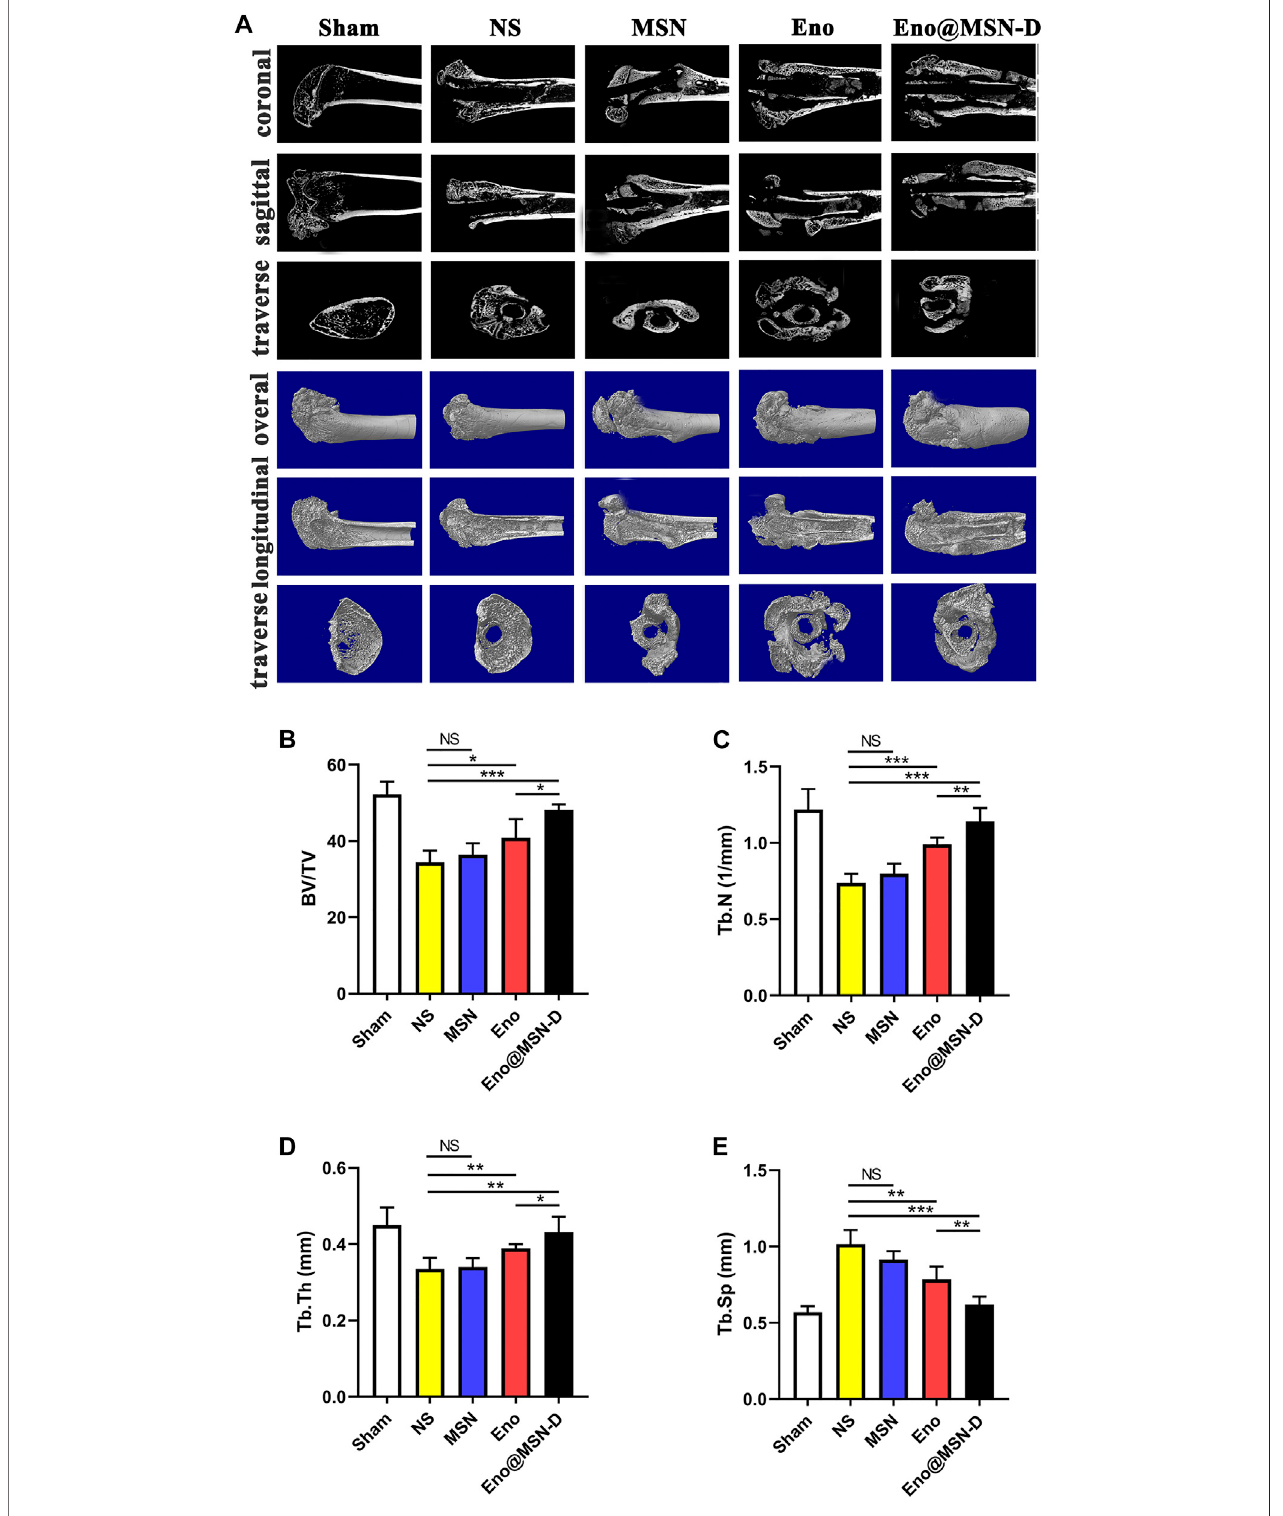
FIGURE9|(A) Coronal, sagittal,and transverse two-dimensionalmicro-CT andintegral,longitudinal,transversethree-dimensional micro-CT imagesofthefemur. (B – E) Statistic diagram of bone volume fraction, number of bone trabeculae, trabecular bone thickness, and trabecular bone separation.